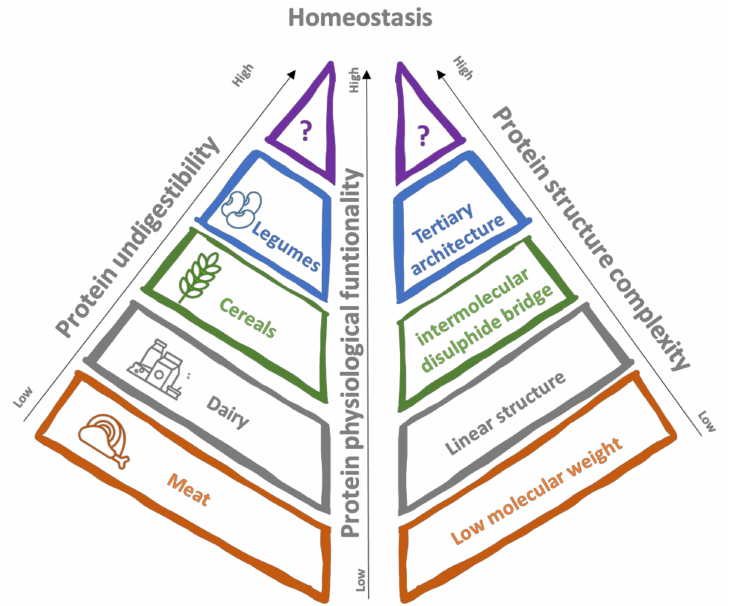
Figure 2. Overall representation of the proteinous fibre concept. The degree of protein indigestibil- ity is strictly influenced by the raw materials where they are sourced and by the different food (bio)processing they undergo during their extraction, purification and subsequent inclusion in food products. However, learned scientist participation in this immature field is eagerly